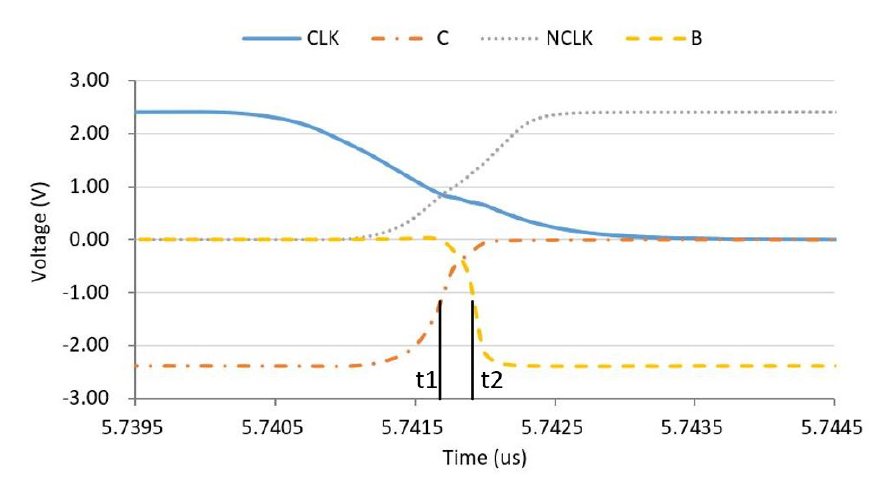
Figure 4. Asymmetry of signals in traditional